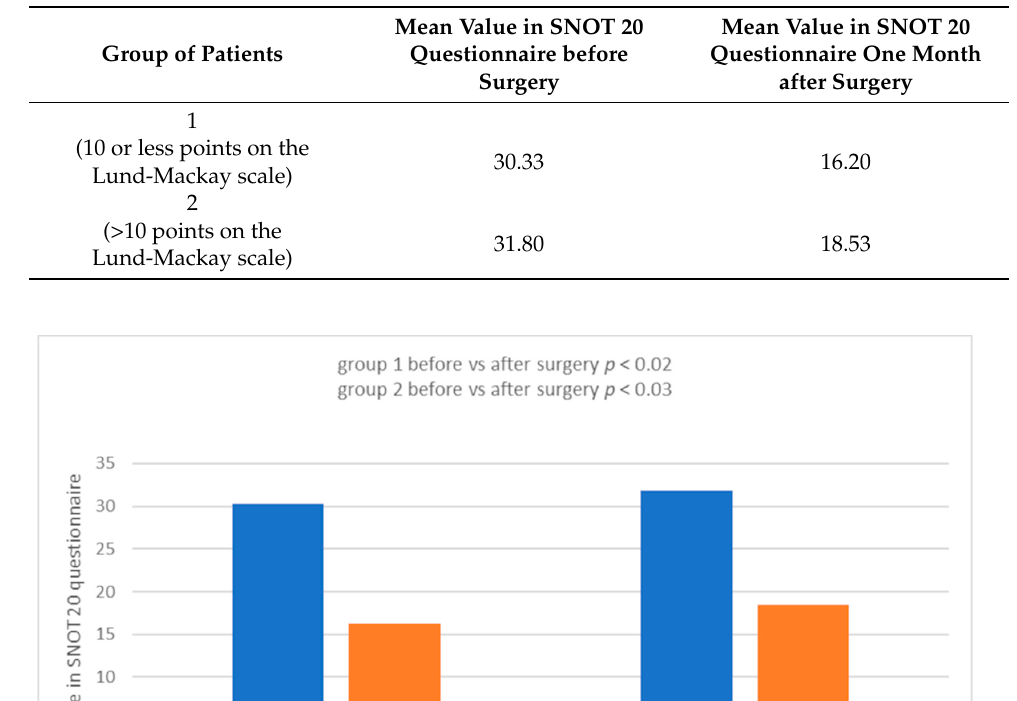
Figure 2. Mean value in Lund-Kennedy endoscopic scale before and one month after surgery in group 1 and 2 (graph). Table 4. Mean value in the Sinonasal Outcome Test SNOT 20 questionnaire before and one month after surgery in group 1 and 2.